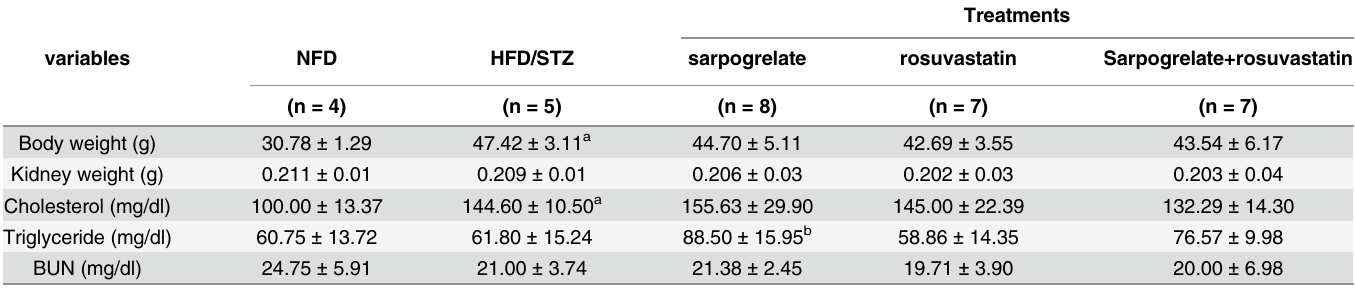
Table 1. After the completion of animal experiment, body weight and kidney weight were determined, and blood levels of cholesterol, triglycerides, and BUN were measured. Data are means ±